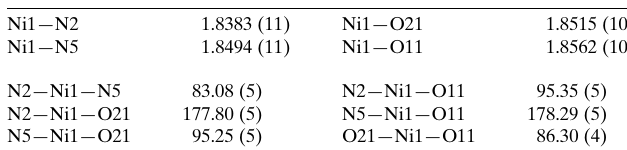
Table 1 Selected geometric parameters (A˚ , (cid:3) ).